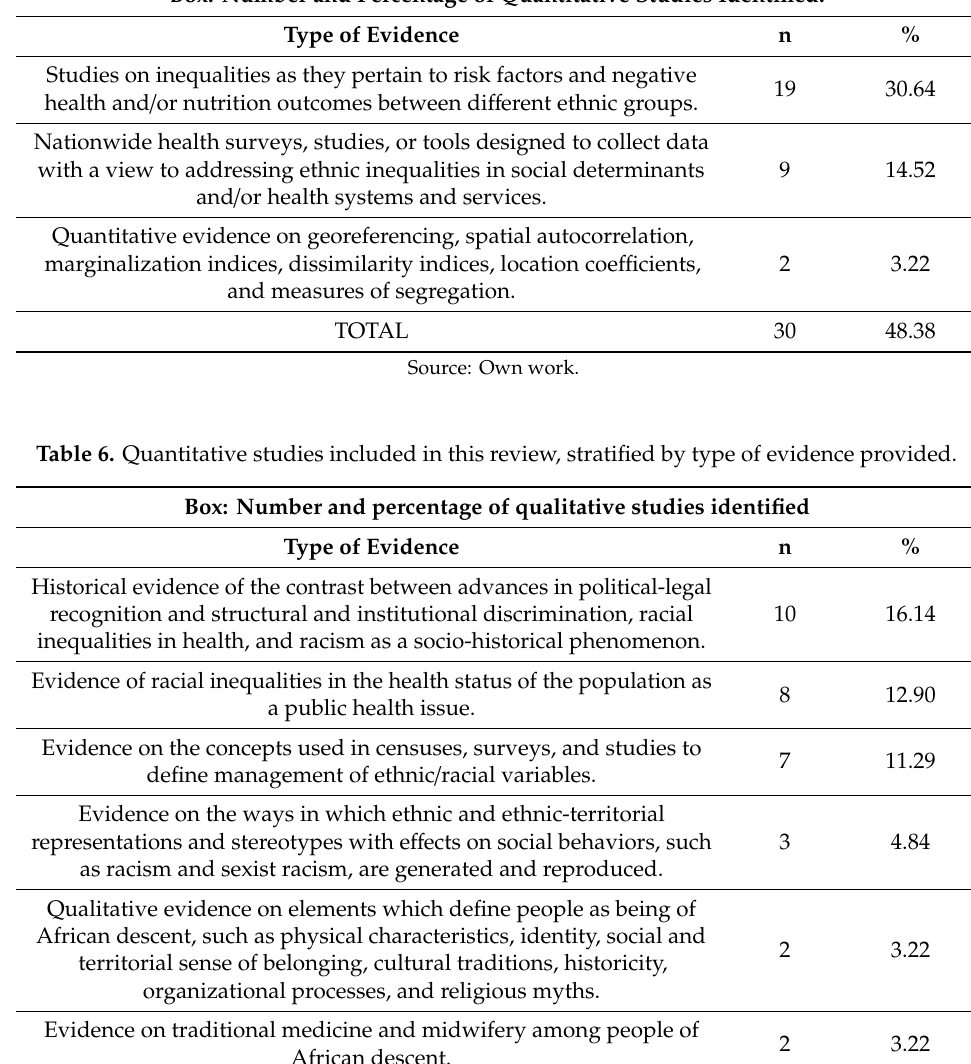
Table 5. Quantitative studies included in this review, stratified by type of evidence provided. Box: Number and Percentage of Quantitative Studies Identified. Type of Evidence